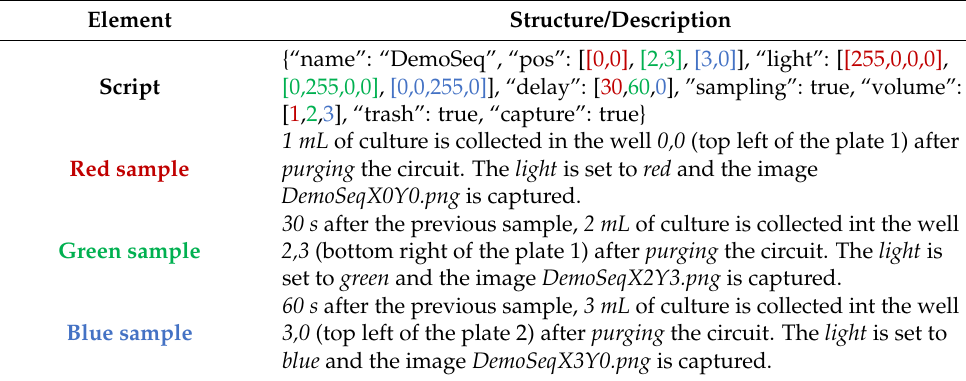
Table 3. Example of automation script that allowed us to collect samples and take pictures without requiring any human